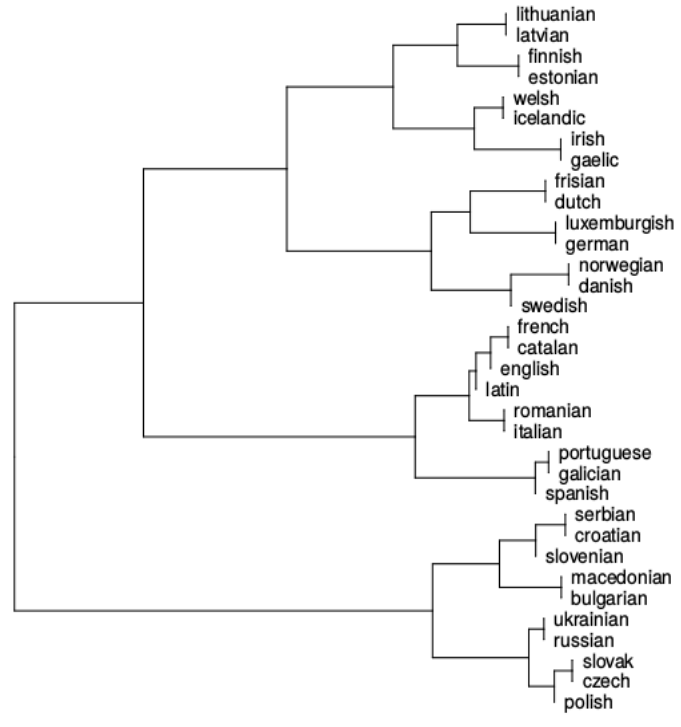
Figure 1. Clusters of languages whose family classification is well known. Stylo configuration: